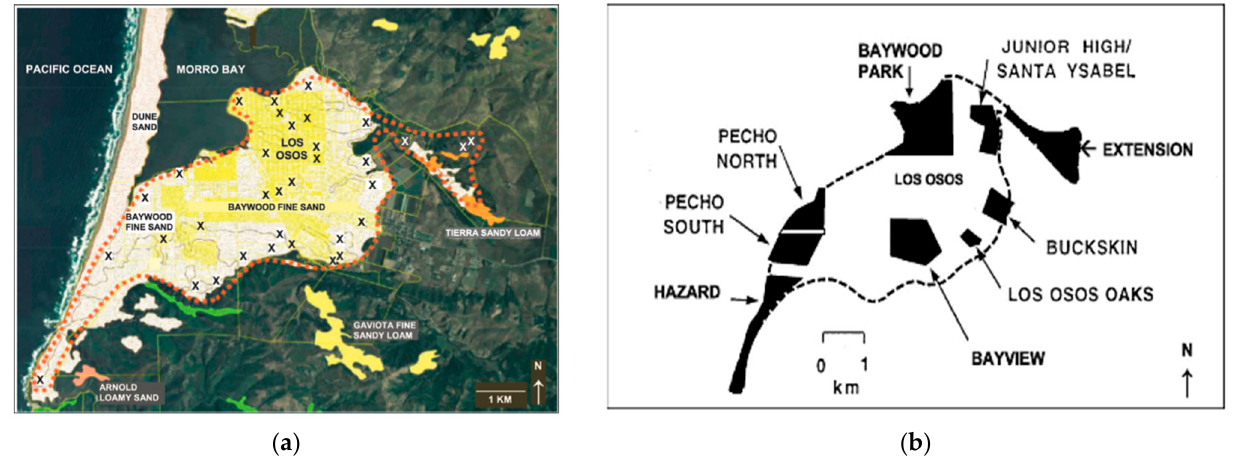
Figure 1. ( a ) The historical geographic range of the Morro Bay kangaroo rat Dipodomys heermanni morroensis (area delimited by orange dots) which is mostly on Baywood Fine Sand (light tan within orange dot outline) in the vicinity of Morro Bay in western San Luis Obispo County, California. Yellow stippling on tan background of Baywood Fine Sand indicates urban development as of 2007. Cross marks (black and white Xs) indicate where Morro Bay kangaroo rats were captured in 1957–1958 in a study to determine the geographic range [18]. Adapted from Kofron and Villablanca [16]. ( b ) Historical survey areas for the Morro Bay kangaroo rat, Dipodomys heermanni morroensis , in the Los Osos area (vicinity of Morro Bay) in western San Luis Obispo County, California. This figure is adapted from U.S. Fish and Wildlife Service [20]. These areas have been the subject of twelve published surveys spanning between 1950 and 2010 reviewed in [16].